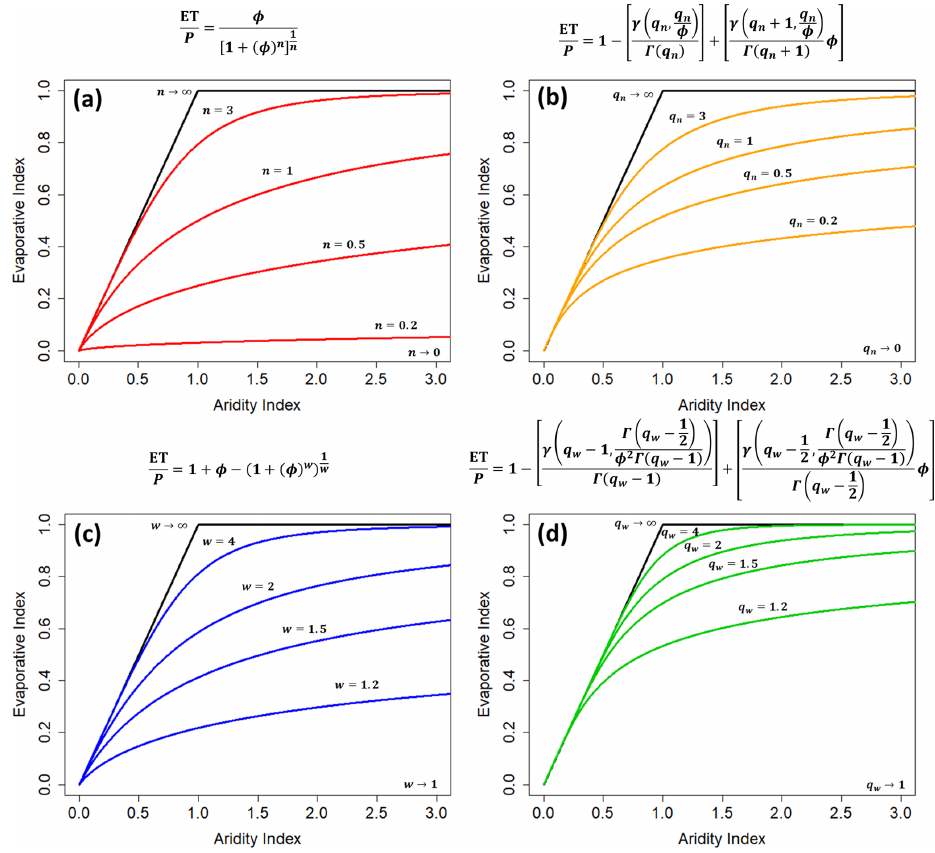
Figure 4. Illustration of the nonuniqueness of the parametric Budyko equations using (a) Eq. (5), (b) Eq. (9), (c) Eq. (6), and (d) Eq. (10), all of which provide equally valid alternative representations of Budyko